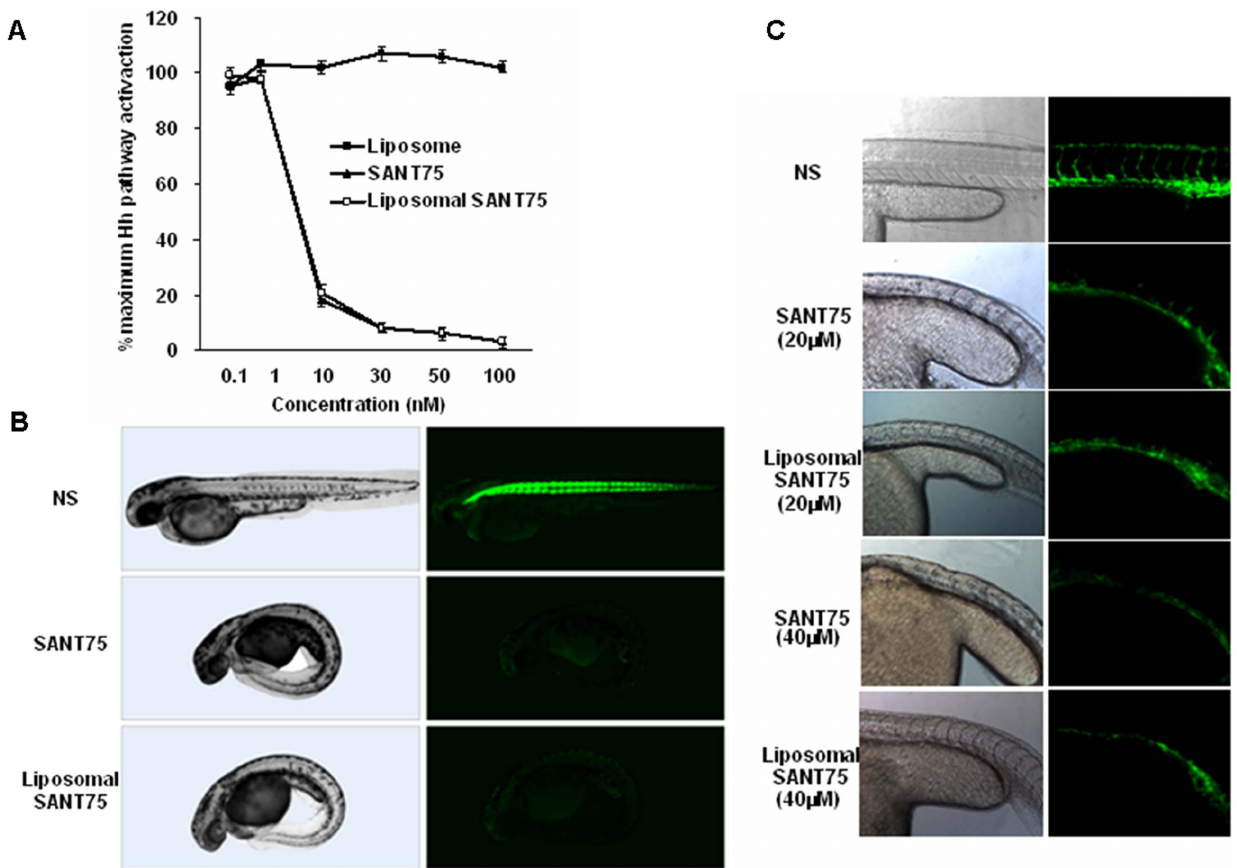
Figure 2.Characterization of liposomal SANT75 in Shh-light2 cell and transgenic zebrafish assays. (A) Inhibition of Hh activation by liposomal SANT75 and free SANT75 in SHh-light2 cells. IC 50s for both are approximately 5 nM. (B) Inhibition of Hh activity in vivo by liposomal SANT75 and free SANT75 using Gli-GFP reporter in transgenic zebrafish embryos. (C) Inhibition of inter-segmental blood vessel by liposomal SANT75 and free SANT75 in Flk-GFP transgenic zebrafish embryos.